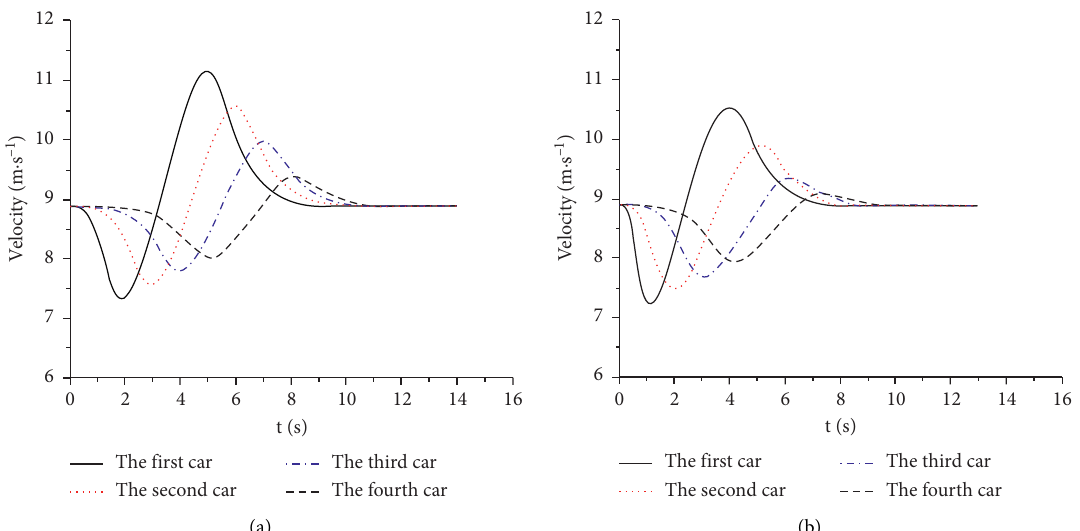
Figure 5: The fluctuation of velocities in different car-following models: (a) the fluctuation of velocity in OV model and (b) the fluctuation of velocity in TOV